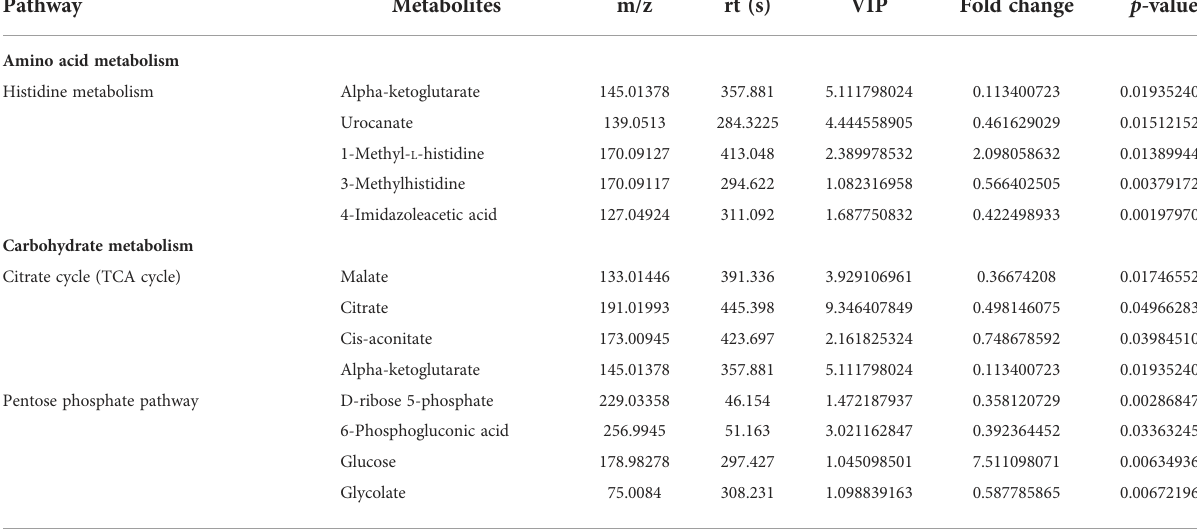
TABLE 2 Altered metabolic pathways and the corresponding differential metabolites in the urine samples from the young and old groups.